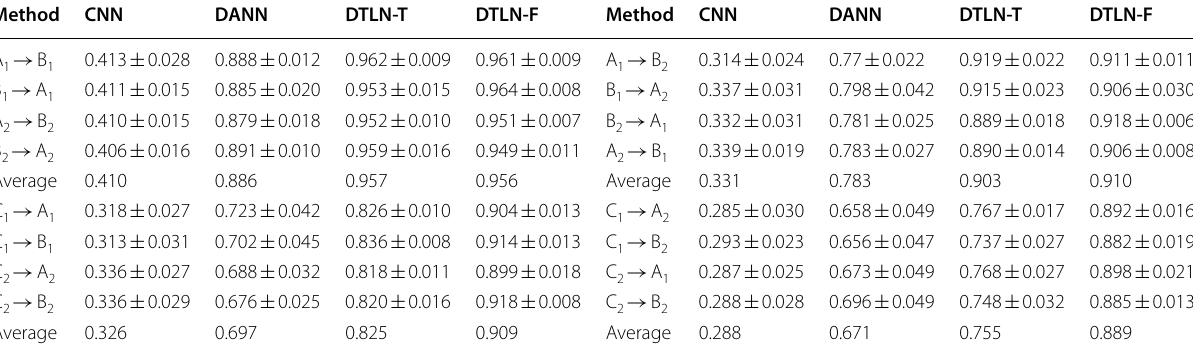
Table 4 Recognition result of